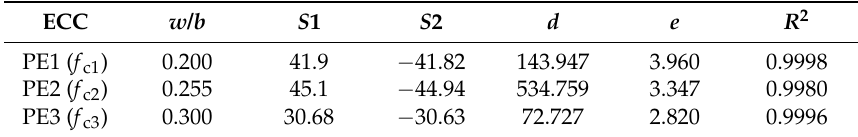
Table 5. Regression coefficients and goodness of fit for Equation (5).